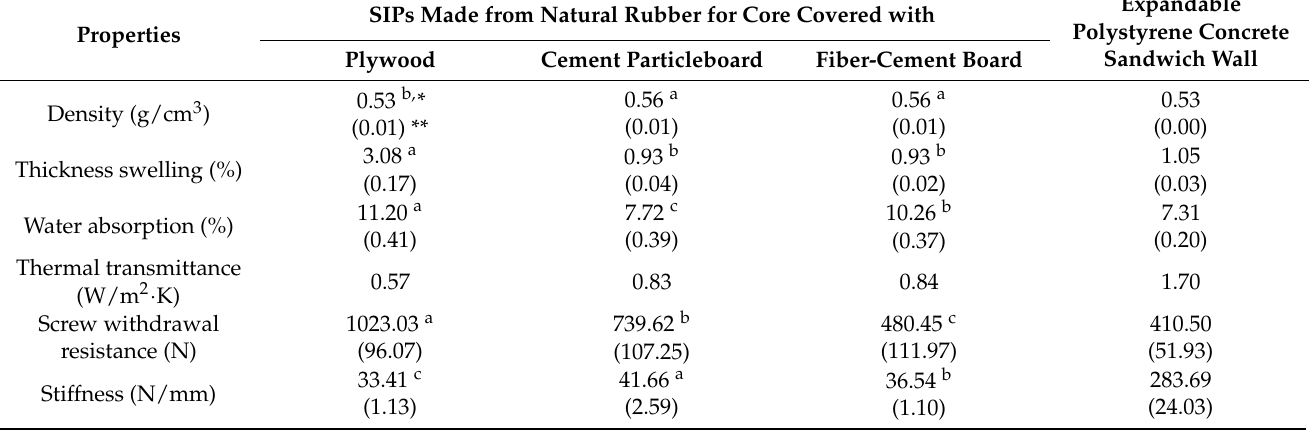
Table 6. Properties of the SIPs made from the wood composite boards and natural rubber foam.